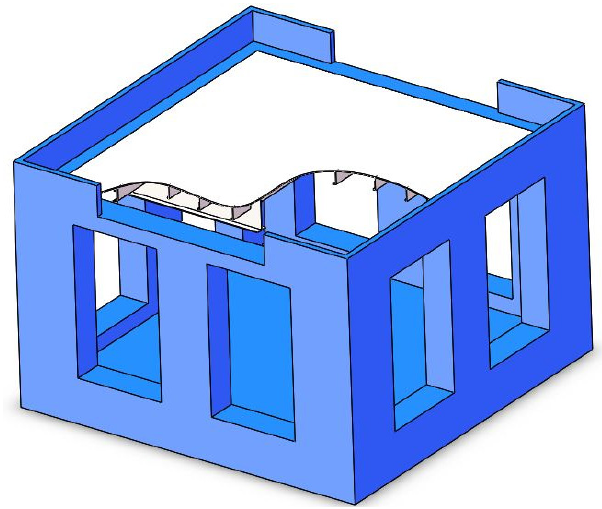
Figure 6. The stiffened panel welded on the support.